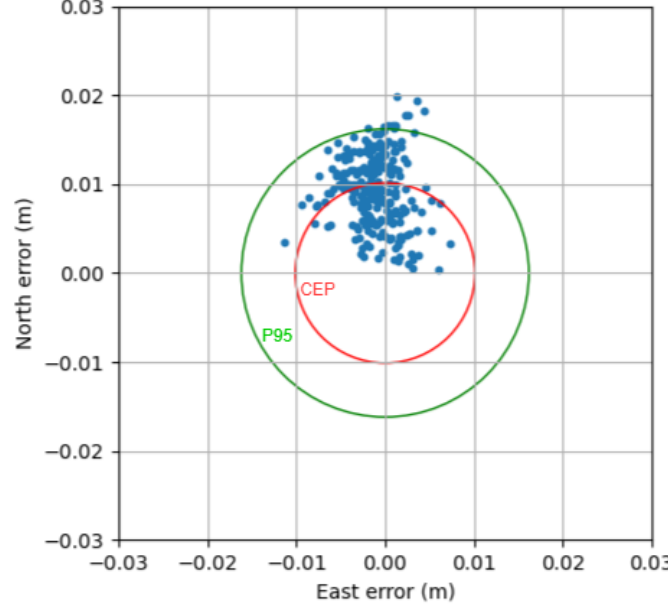
Figure 12. Horizontal positioning errors in East and North under a 5 km